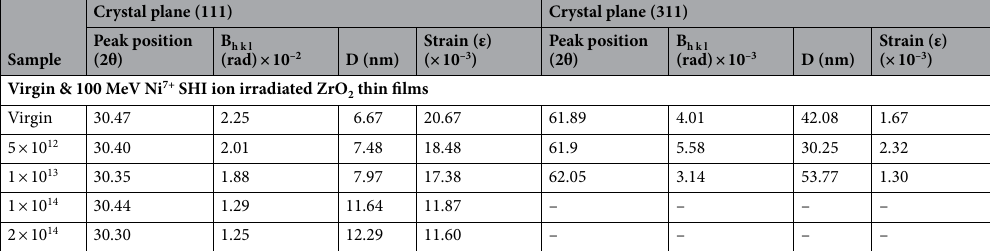
Table 1. Crystallite size and strain measurements from XRD data of virgin and Ni beam irradiated ZrO 2 thin films with ions fluence of 5 × 10 12 , 1 × 10 13 , 1 × 10 14 and 2 × 10 14 ion/cm 2 .